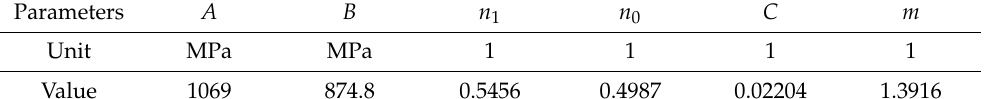
Table 5. Parameters of the KHL model for Ti–6Al–4V ( T m = 1933 K) [14].